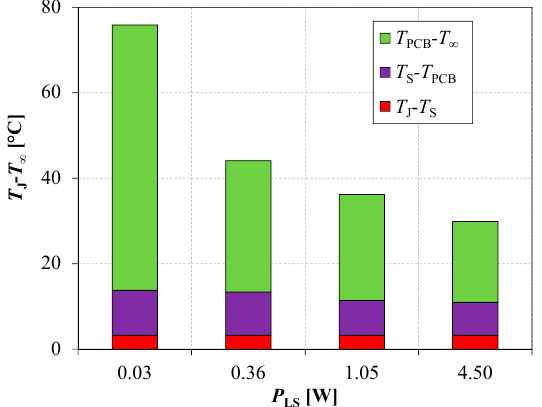
Figure 14. The temperature budget between the LED junction and the ambient.